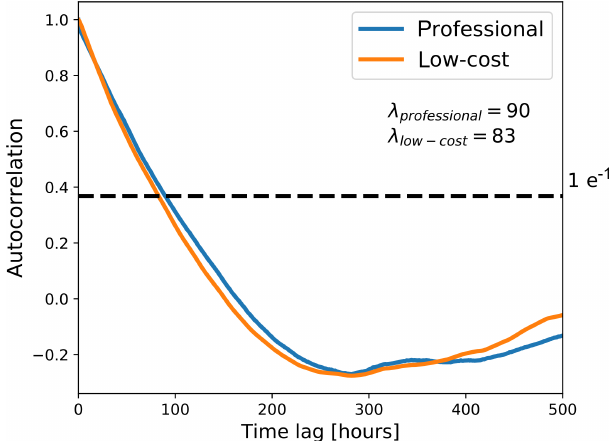
Figure 11. Autocorrelation function and e -folding times, λ , for the catchment average based on the FP sensors and the professional probes at a depth of